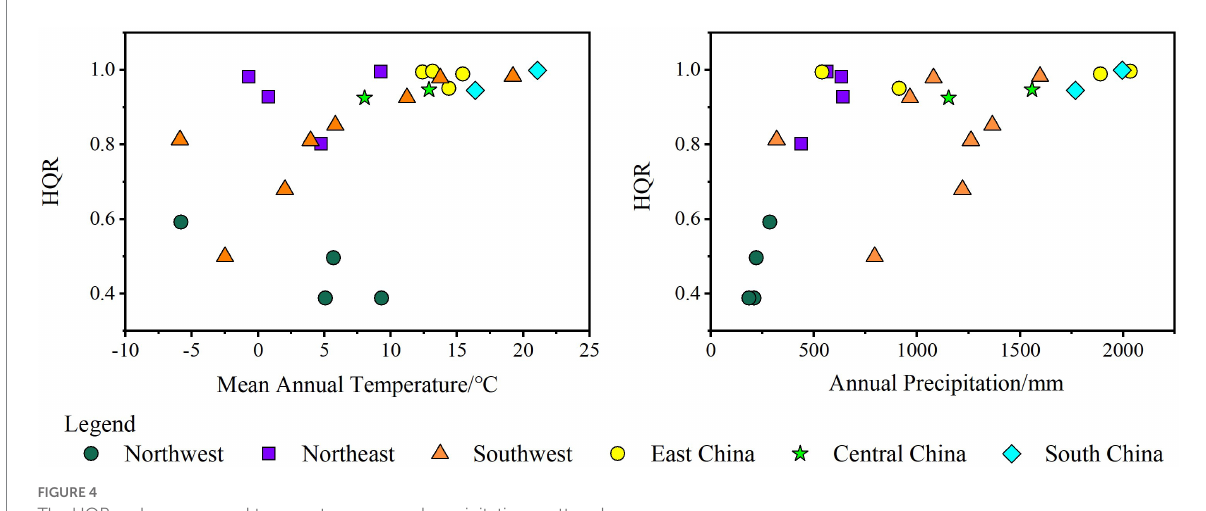
FIGURE 4 The HQR and mean annual temperature – annual precipitation scattered map.